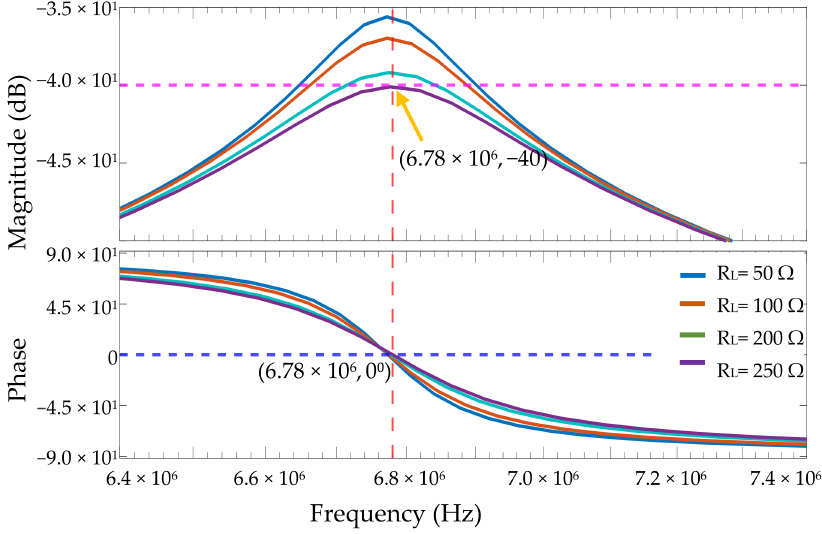
Figure 7. | I 1 / V i | value in magnitude and phase.